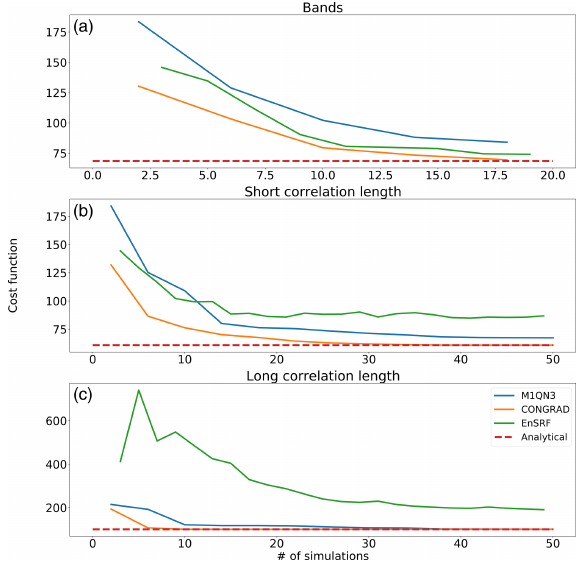
Figure 8. Cost function evaluation for varying numbers of com- puted simulations for analytical (red), EnSRF (green), variational with CONGRAD (orange) and variational with M1QN3 (blue) methods. (a) Inversion set-up with aggregated regions of 3 × 3 pix- els; (b) inversion set-up at the pixel resolution with horizontal cor- relation length of 500m; (c) inversion set-up at the pixel resolution with horizontal correlation length of